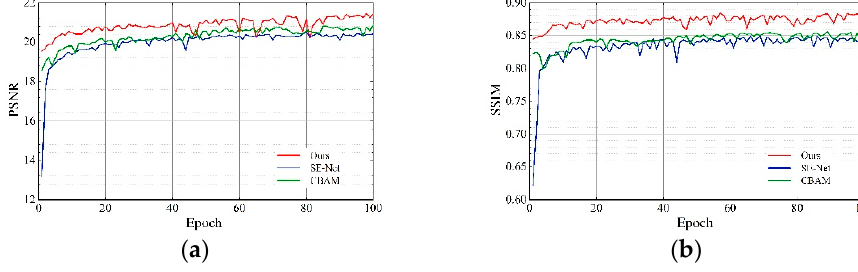
Figure 7. Effects of ablation study (2). Table 4. Average PSNR/SSIM of ablation study (2).